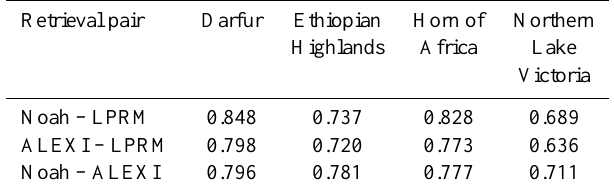
Table 5. Average anomaly correlations.